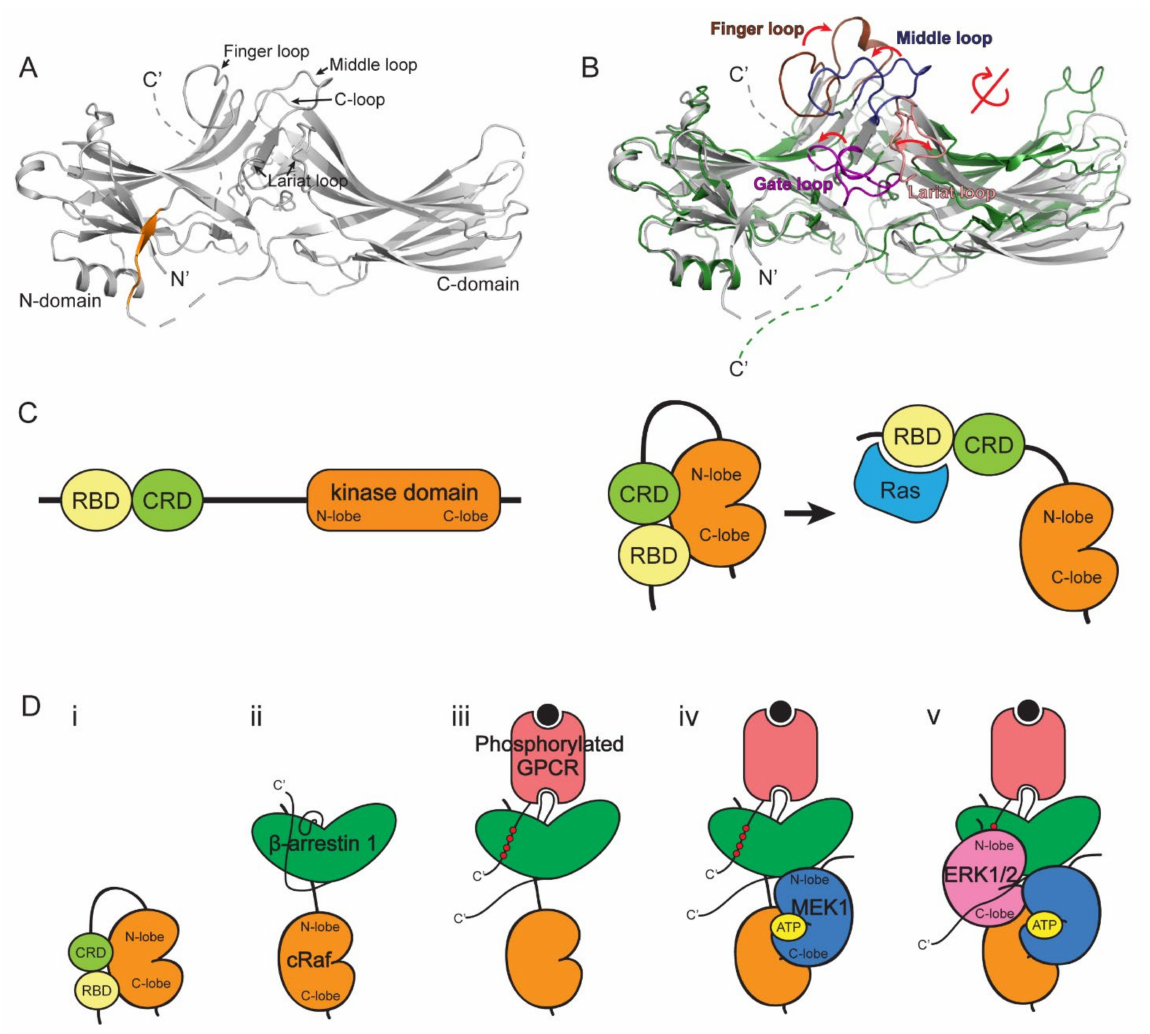
Figure 2. The structures of β -arrestin and the scaffolding mechanism of ERK1/2 signaling cascade. ( A ) The structure of β -arrestin 1 in the basal state (PDB: 1G4R). The C-terminal β XX strand is colored in orange. ( B ) Comparison of β -arrestin in the basal and active states. The structures of β -arrestin 1 in basal (grey, PDB: 1G4R) and NTSR1-bound active (green, PDB: 6UP7) states are compared. The loops on β -arrestin 1 are colored as follows: finger loop, brown; middle loop, dark blue; gate loop, purple; lariat loop, salmon. ( C ) The representation of cRaf domains (left) and conformational changes of cRaf upon Ras binding (right). ( D ) The proposed model of the scaffolding mechanism of ERK1/2 signaling cascade by β -arrestin 1. (i) cRaf is auto-inhibited by the N-terminal domains, including RBD and CRD. (ii) cRaf RBD interacts with the back loop of β -arrestin 1. (iii) The phosphorylated GPCR may bind to β -arrestin 1. (iv) The N-lobe of MEK1 interacts with the interdomain loop I of β -arrestin 1. (v) The activated β -arrestin 1 interacts with ERK1/2 between the gate loop of β -arrestin 1 and the N-lobe of ERK1/2 and the interdomain loop II of β -arrestin 1 and the C-lobe of